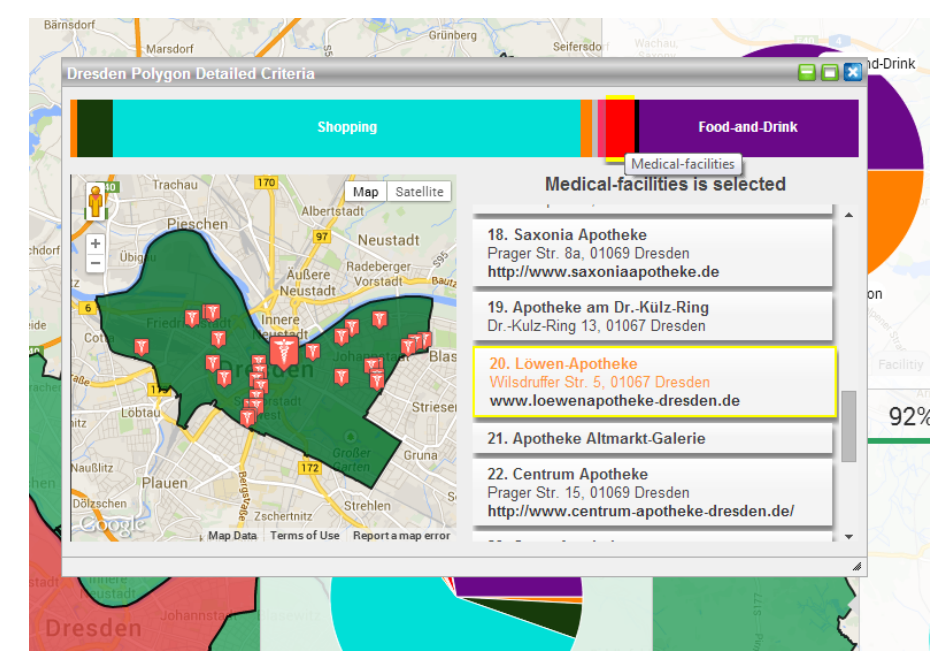
Figure 6 . Detailed exploration of geo-located